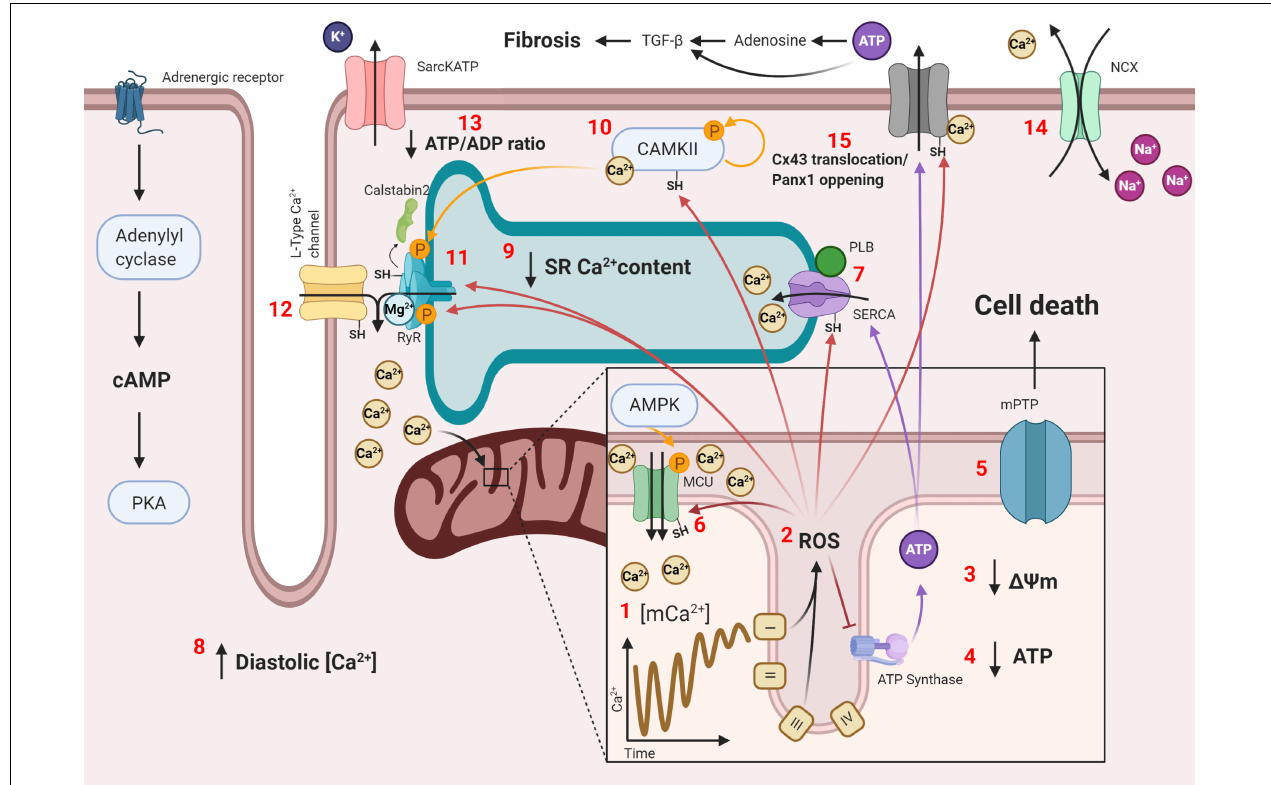
FIGURE 2 | Mitochondria-SR-T tubule communication in arrhythmogenesis. Conditions that favor Ca 2 + overload, such as chronic adrenergic stimulation, cause the following: (1) increased Ca 2 + transport through the mCU to the mitochondrial matrix, shortening mitochondrial Ca 2 + transients’ amplitude and stabilizing the mitochondrial Ca 2 + concentration at a high level, which causes mitochondrial Ca 2 + overload; (2) increased ROS production by mitochondrial structures, such as the ETC, with subsequent (3) loss of (cid:49)(cid:57) m and (4) decreased ATP production; (5) opening of the mPTP, which initializes the cell death signal; (6) increased mCU activity by oxidation and, possibly, AMPK phosphorylation following a decline in the ATP concentration, which increases Ca 2 + transport and ROS production; (7) decreased SERCA activity by oxidation and decreased PLB phosphorylation, which (8) increases the diastolic Ca 2 + level and (9) decreases SR Ca 2 + content, reducing contractility; (10) increased CAMKII activity by Ca 2 + activation, oxidation, and autophosphorylation; (11) sensibilization of the RyR2 to luminal Ca 2 + content with a reduced refractory state by oxidation and CAMKII hyperphosphorylation, with a subsequent unbinding of its modulating protein, calstabin2, and lower sensitivity to cytosolic Ca 2 + by Mg 2 + binding; (12) oxidation of LTCCs, which increases the amount of Ca 2 + entering the cardiomyocyte upon activation; (13) opening of sarcKATP channels due to a reduced ATP/ADP ratio, which decreases the cardiomyocyte’s bathmotropism and dromotropism; (14) increased activity of the NCX, which slowly depolarizes the cardiomyocyte and increases the risk of an unsolicited AP; (15) connexin 43 (Cx43) translocation in certain cardiac pathologies or pannexin 1 (Panx1) opening with Ca 2 + or ROS transports ATP into the extracellular matrix, where it is transformed into adenosine, and both ATP and adenosine cause TGF- β 1 expression and fibrosis. All these changes combined produce, at the cellular level, Ca 2 + mishandling with subsequent low contractility and spontaneous contraction that can propagate to neighboring cardiomyocytes and, at the tissular level, patches of slow conduction by reduced dromotropism or collagen deposition caused by cardiomyocyte cell death and fibrosis, which enable possible re-entry zones for sustained arrhythmias.